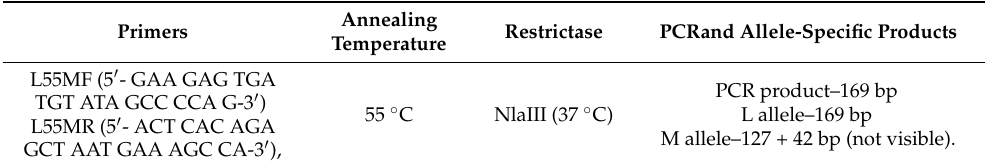
Table 2. Primer sequences, size of the PCR product and restriction fragments, the annealing tempera- ture and restriction enzyme used in PCR-RFLP method for genotyping for PON1 L55M (rs 854560). Annealing Primers Restrictase PCRand Allele-Specific Temperature